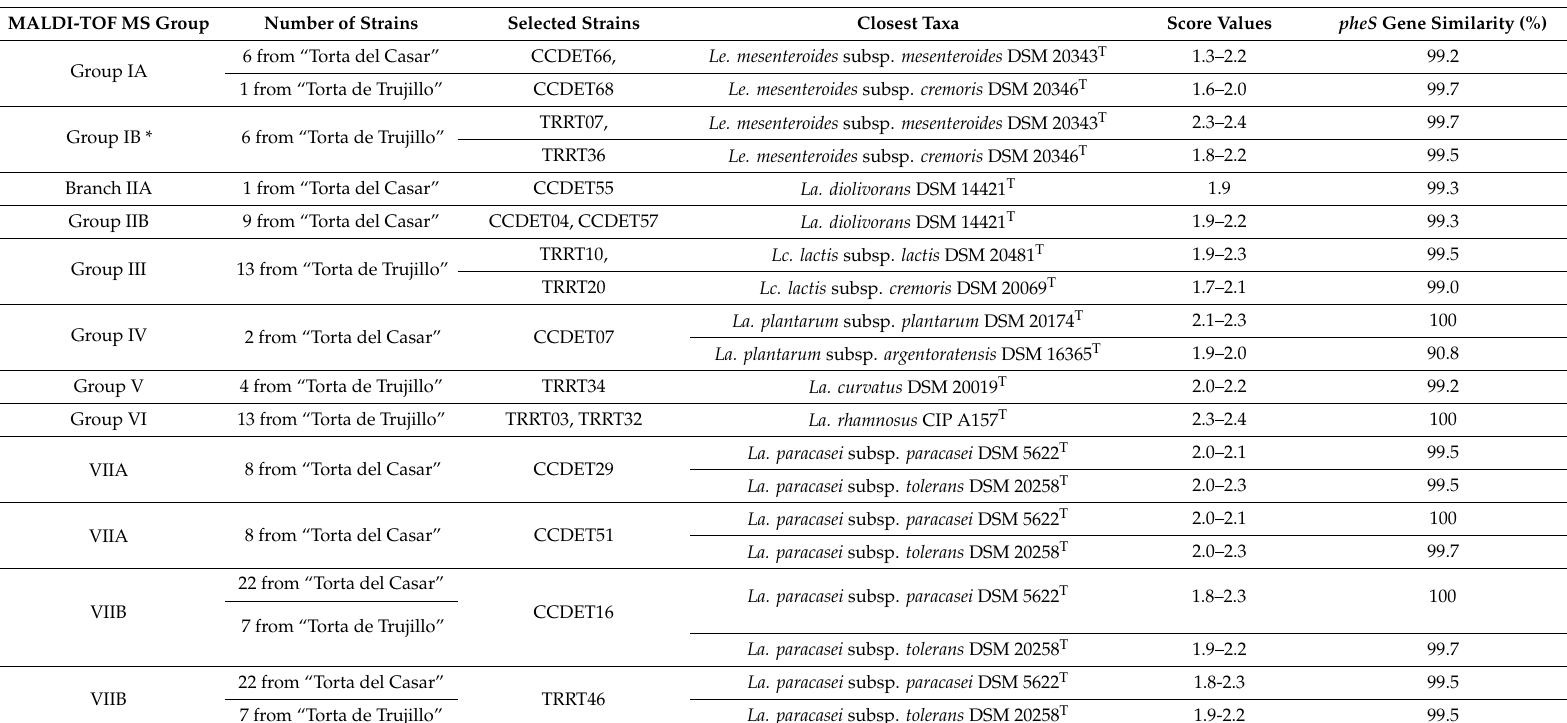
Table 3. Results obtained using MALDI-TOF MS and pheS gene